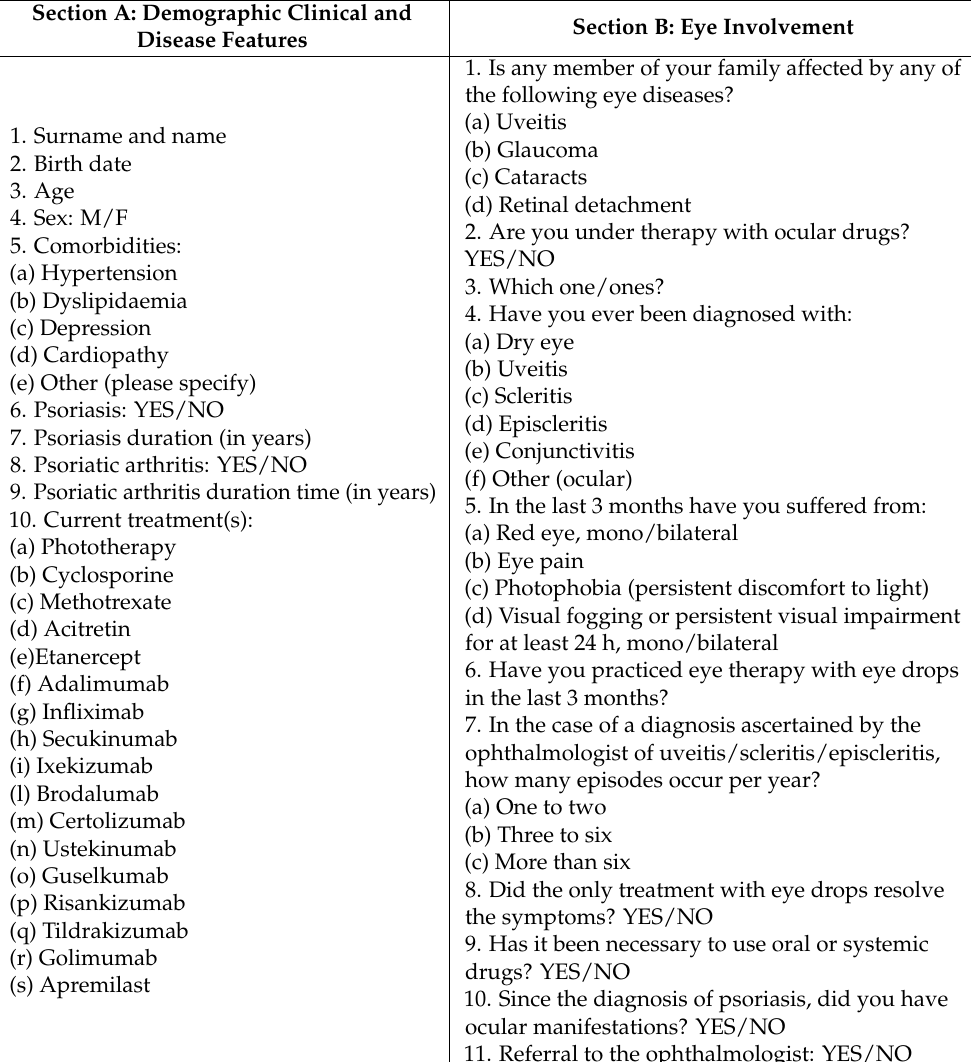
Table 1. OcMaPS (Ocular Manifestations in in Psoriasis Screening)